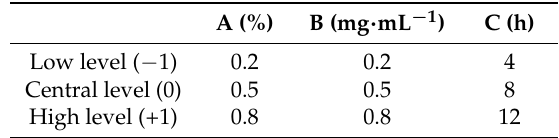
Table 2. Experimental levels of variables in the Box–Behnken experimental design.